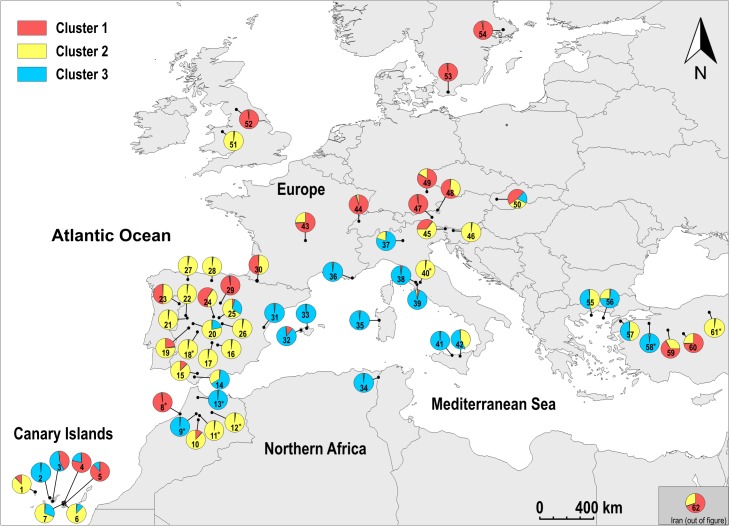
Distribution of the clusters at each site.Proportion of membership of each site in the three clusters inferred by Structure. Collection sites numbered as in S1 Table. Localities where only one individual was studied are marked with an asterisk.